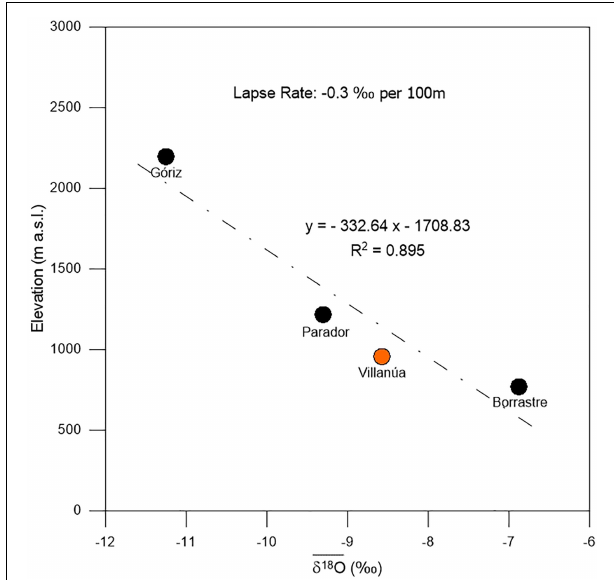
FIGURE 5 | Relationship between elevation and δ 18 O of different rainfall sampling sites in Pyrenees. δ 18 O rainfall mean values are obtained by the weighted average of rain events values in Borrastre ( n = 373) and Villanúa ( n = 210). For Góriz and Parador, δ 18 O values of rainfall samples are seasonal averaged and calibrated with a sinusoidal equation (Jódar et al., 2016).